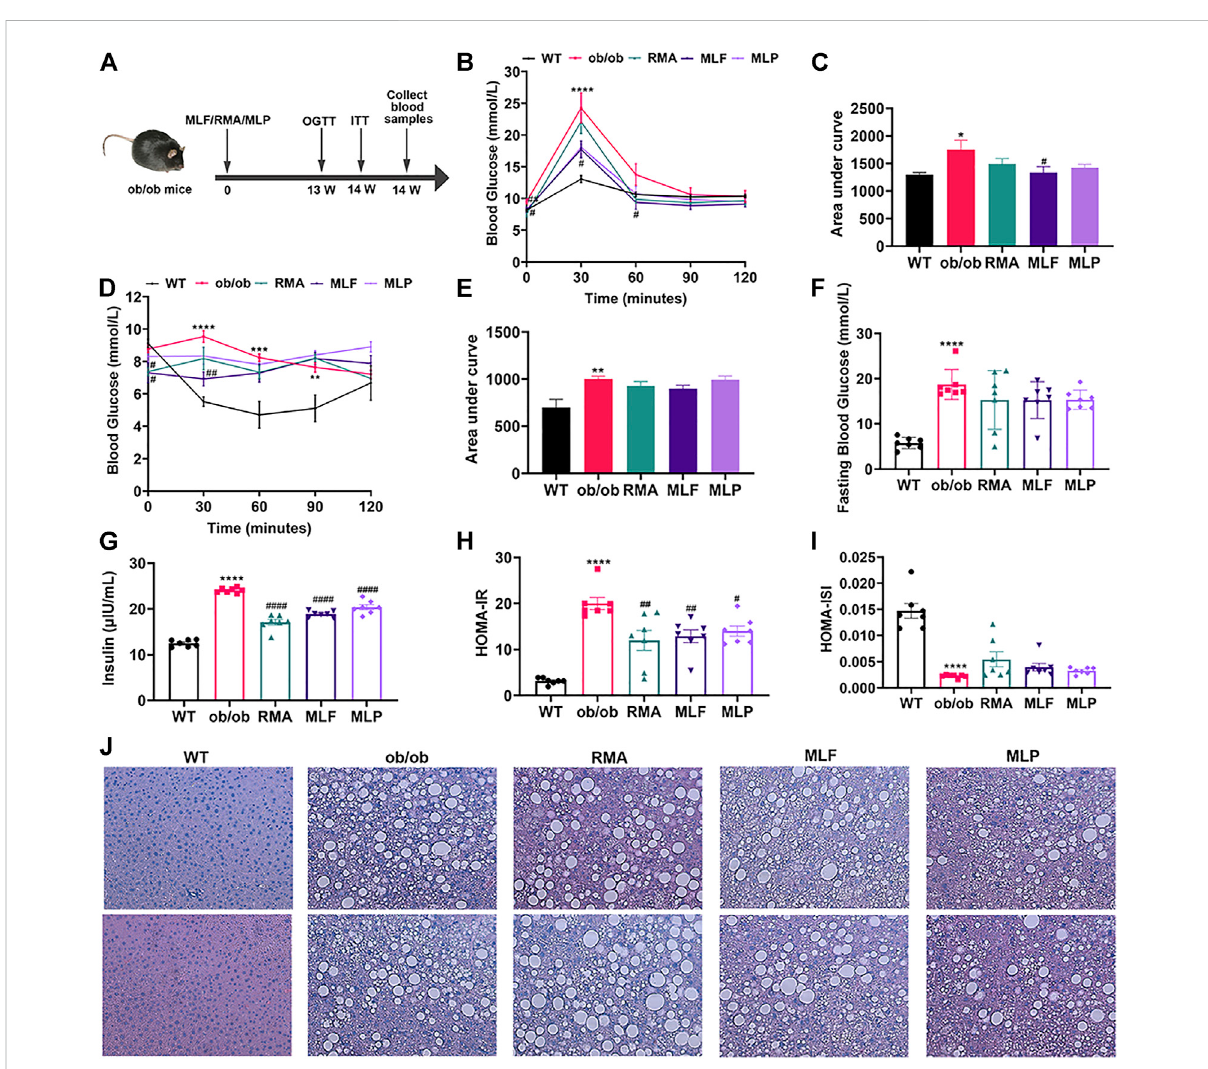
FIGURE 4 MLF and MLP treatment improved metabolic parameters of glucose tolerance and insulin resistance, and alleviated hepatic steatosis in ob/ob mice. (A) Experimental scheme of the ob/ob mouse protocol. (B) OGTT (oral glucose tolerance tests) and (C) AUC of the OGTT on the 13th week of treatment in ob/ob mice. (D) ITT (insulin tolerance tests) and (E) AUC of the ITT on the 14th week of treatment in ob/ob mice. (F) Fasting blood glucose in serum. (G) Serum insulin levels. (H) HOMA - IR index. (I) HOMA - ISI index. (J) Representative pictures of liver stained with H&E (magni fi cation: ×40). * p < 0.05, ** p < 0.01, *** p < 0.001, **** p < 0.0001, compared with WT group; # p < 0.05, ## p < 0.01, ### p < 0.001, #### p < 0.0001, compared with the ob/ob